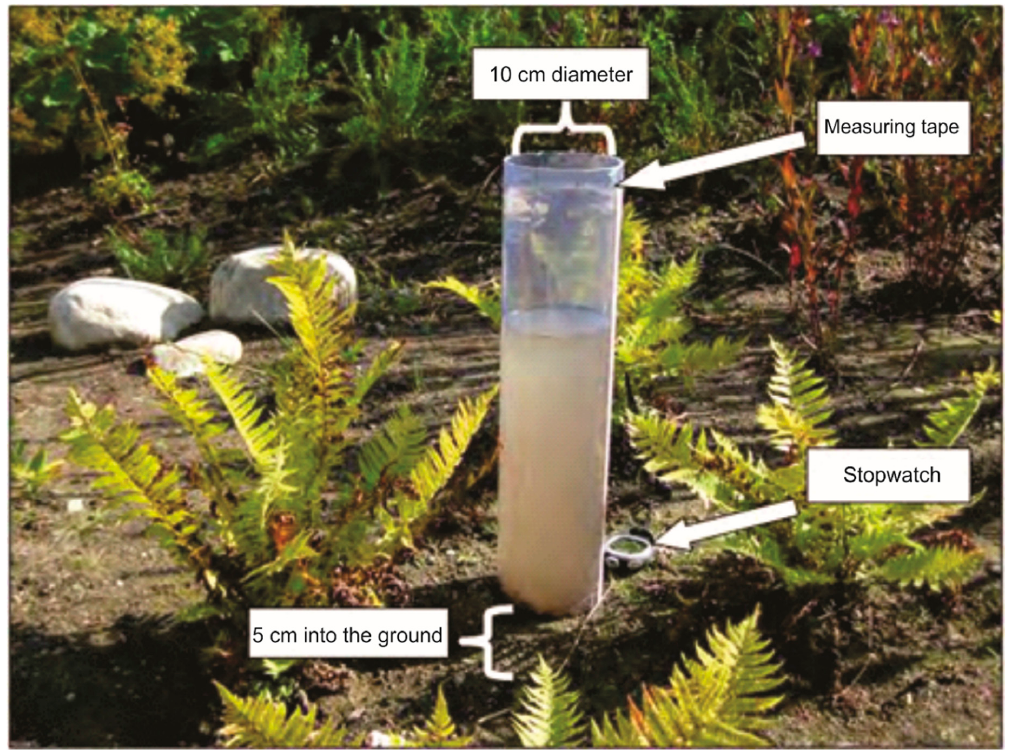
Figure 5. Modified Philip–Dunne (MPD) column for infiltration measurements (Photo: Tone M. Figure 5. ModifiedPhilip–Dunne(MPD)columnforinfiltrationmeasurements(Photo: